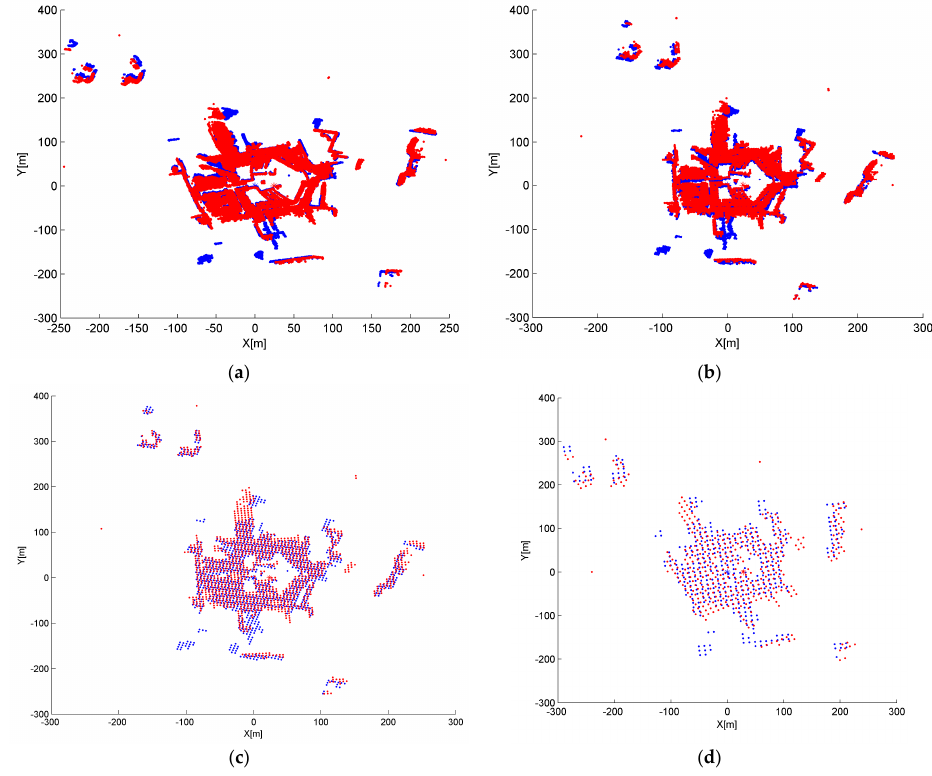
Figure 9. Nadir view of the spatial distributions for S1 and S2 after IME when: ( a ) d G = 1 m; ( b ) d G = 2.5 m; ( c ) d G = 5 m; and ( d ) d G = 10 m, and t G is fixed to 10 m.